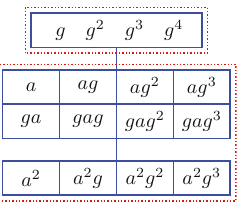
Figure 1: The eggbox picture of S 1 and its archimedean components.